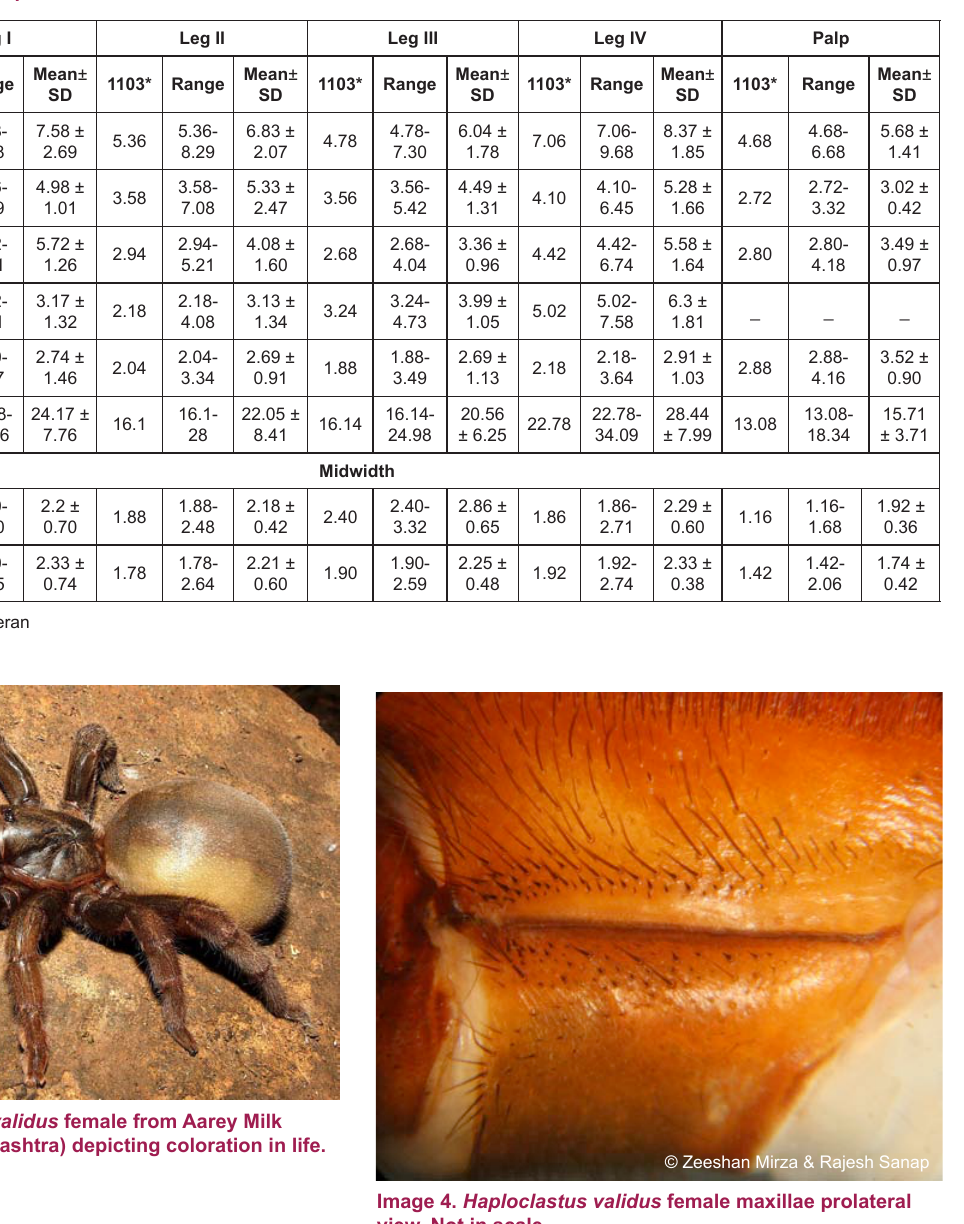
Table 2. H. validus, measurements of legs and palp of female specimen from Matheran, WILD-10-ARA-1103. Ranges and mean include all female specimens collected from Maharashtra